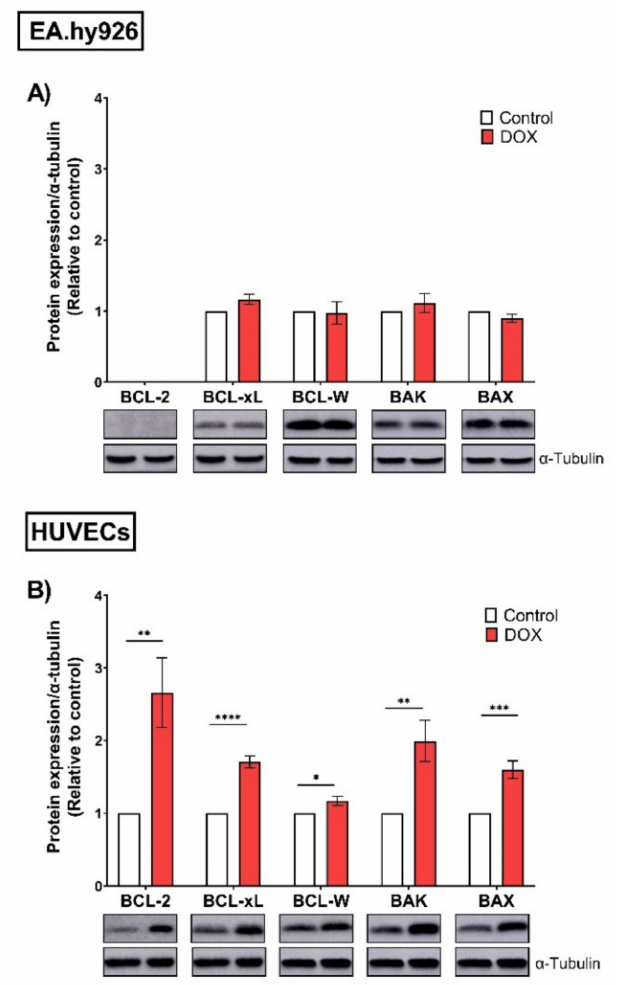
Figure 7. EA.hy926 and HUVECs demonstrate differential protein expression of the BCL-2 family following DOX treatment. Both EA.hy926 cells and HUVECs were treated with 0.5 µ M DOX for 24 h. Three days post DOX exposure, cells were harvested and total protein was extracted. Thereafter, protein expression levels of the BCL-2 family including anti-apoptotic members (BCL-2, BCL-xL, and BCL-W) and pro-apoptotic members (BAK and BAX) in ( A ) EA.hy926 cells and ( B ) HUVECs were measured via Western blotting ( n = 4–6). Representative images of Western blots are shown. Values were normalized to α -tubulin and expressed relative to control cells. Values are presented as means ± SEM. Data were analyzed by unpaired two-tailed t-test. Note: * p < 0.05, ** p < 0.01, *** p < 0.001, **** p <